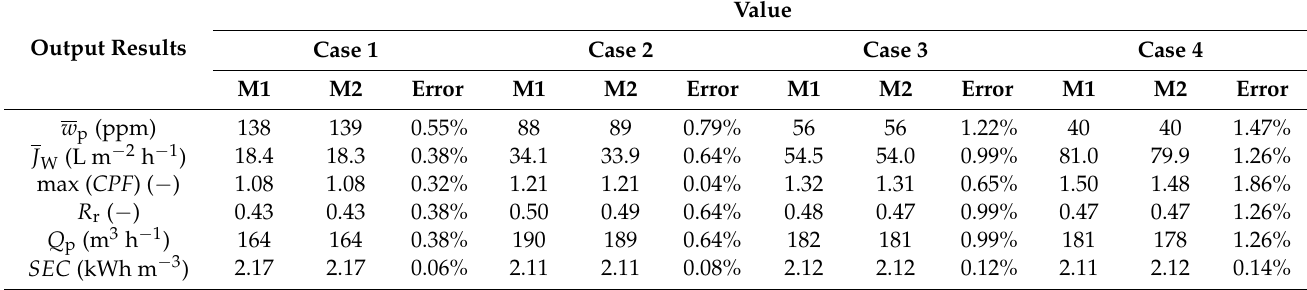
Table 3. Output results and errors analysis at the system-level coupling with the impermeable wall